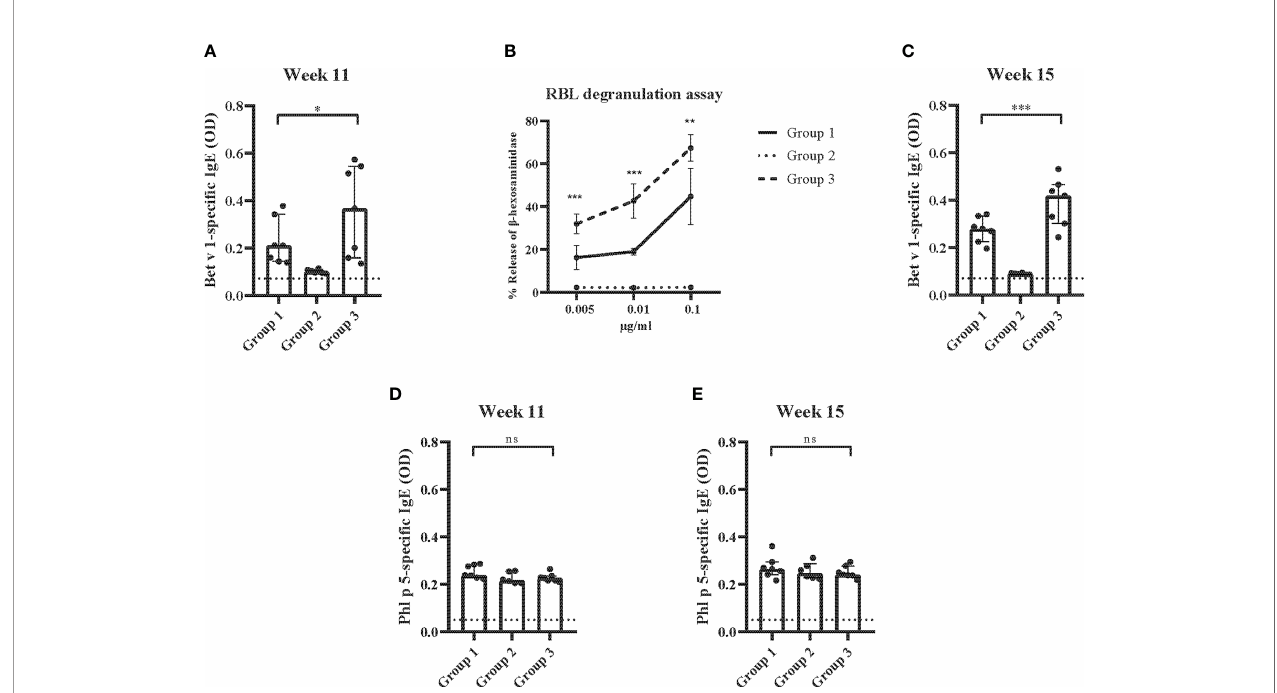
FIGURE 7 | Allergen-speci fi c IgE responses and basophil activation after prophylactic administration of Bet v 1 peptides. (A) Bet v 1-speci fi c IgE antibody levels of the three mouse groups at week 11 ( y-axes : optical density OD levels, group medians with interquartile ranges). (B) Bet v 1-speci fi c basophil degranulation (0.005µg/ ml, 0.001µg/ml, 0.1µg/ml; x-axis ) in the three mouse groups at week 11. The percentages of total b -hexosaminidase release are displayed on the y-axis. (C) Bet v 1- speci fi c IgE at week 15 (y-axes: optical density, OD levels, group medians with interquartile ranges). Phl p 5-speci fi c IgE antibody levels in the three mouse groups at week 11 (D) and at week 15 (E) (y-axes: optical density, OD levels, group medians with interquartile ranges). Dot represents means of duplicate determinations in individual mice with less than 10% deviation. Dotted horizontal bars indicate the cut-off levels for the antibody measurements. Data were analyzed by a general linear model with a log link, comparing group 1 and 3 by linear contrast. Statistically signi fi cant differences between group 1 and group 3 are indicated (***P < 0.001, **P < 0.01, *P < 0.05). ns, not signi fi